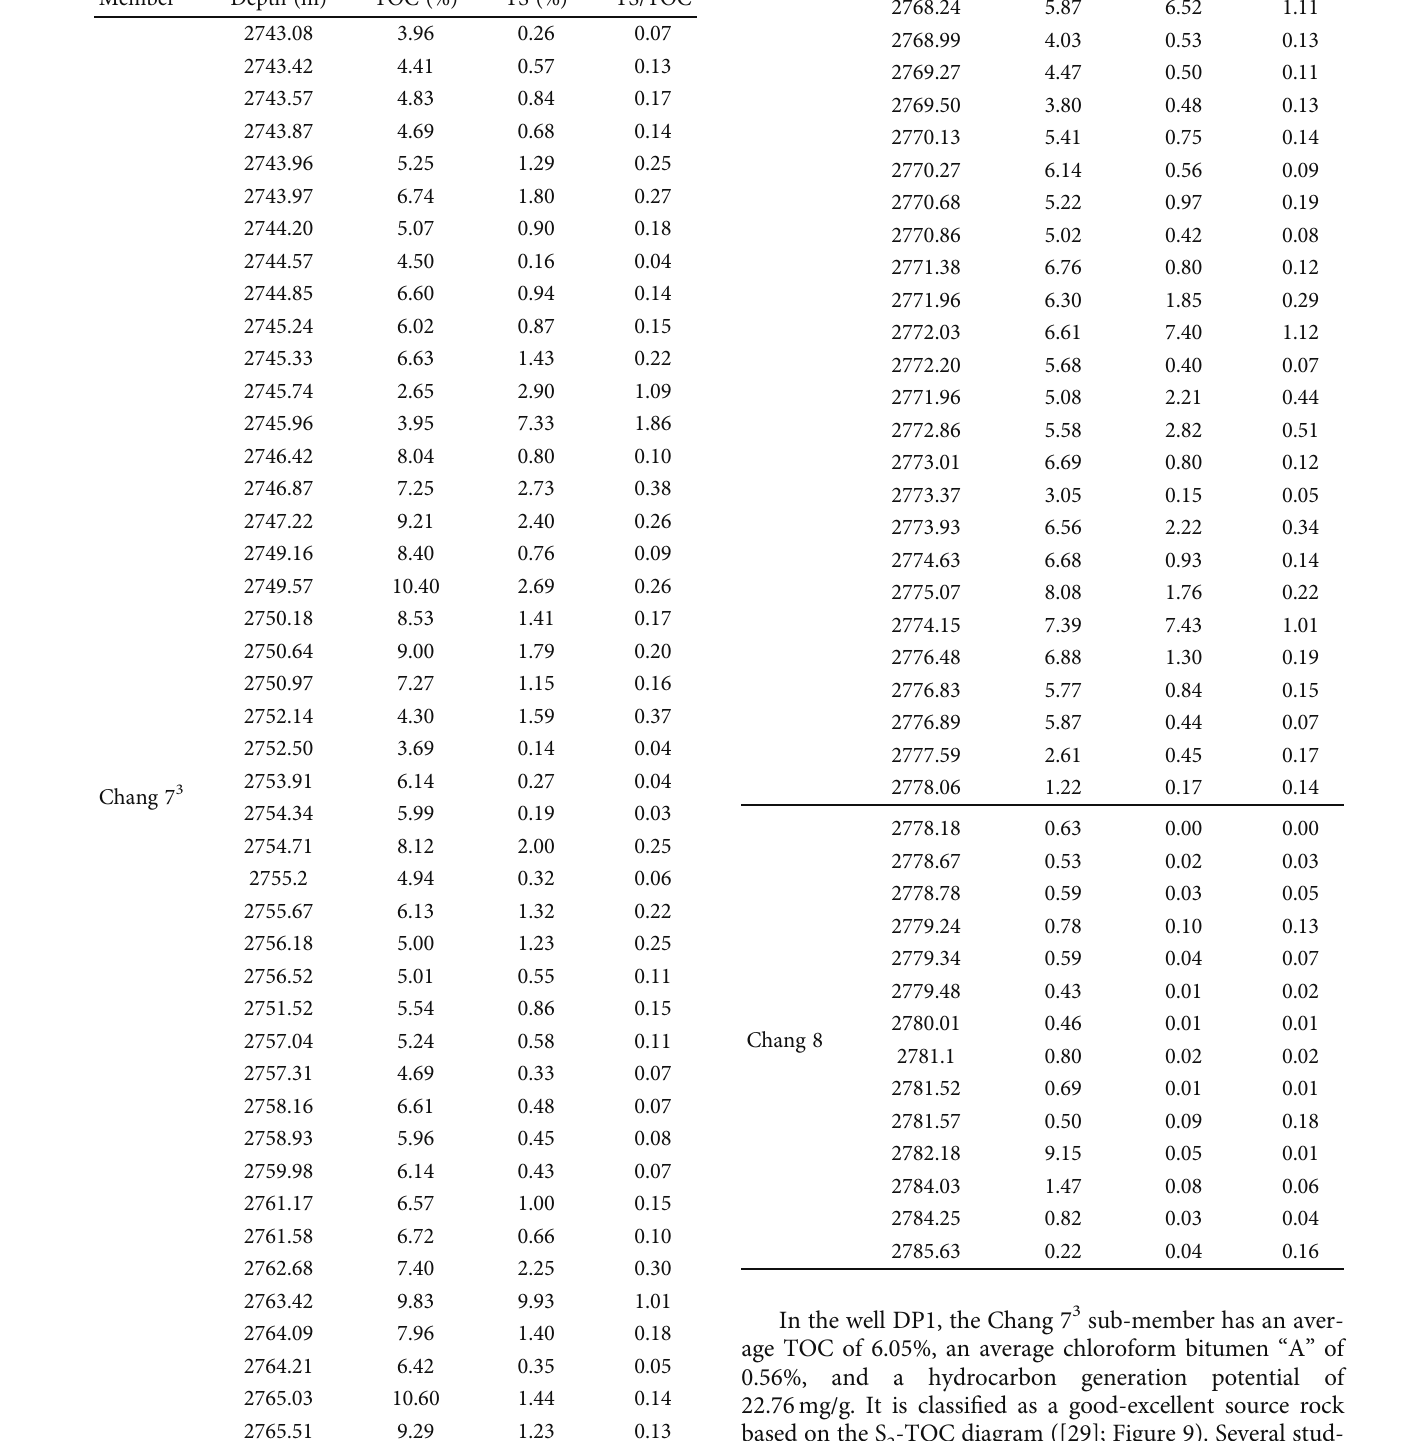
Table 2: The TOC and TS content of Chang 7 3 and Chang 8 intervals from well DP1 in the western Ordos Basin.